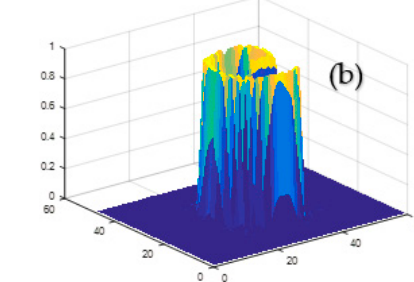
Table 5. The respective PSNR and SSIM for different methods (object “+”).